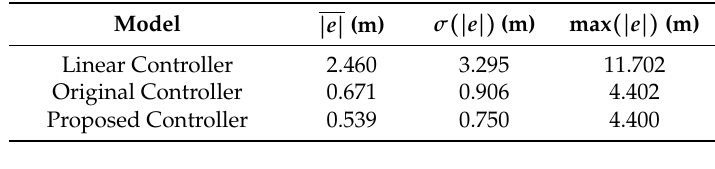
Table 2. Comparison of control results of different controllers.